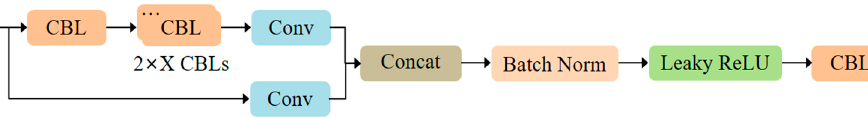
Figure 7. Composition of the CSP2_X block .